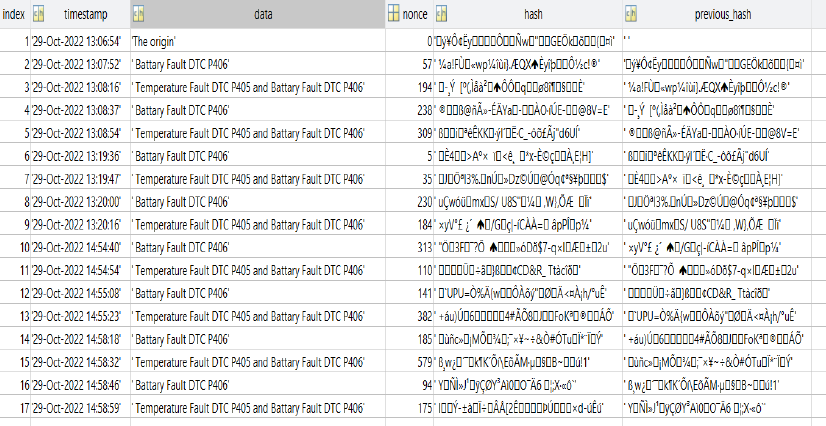
Figure A7. The final content of Blockchain after several